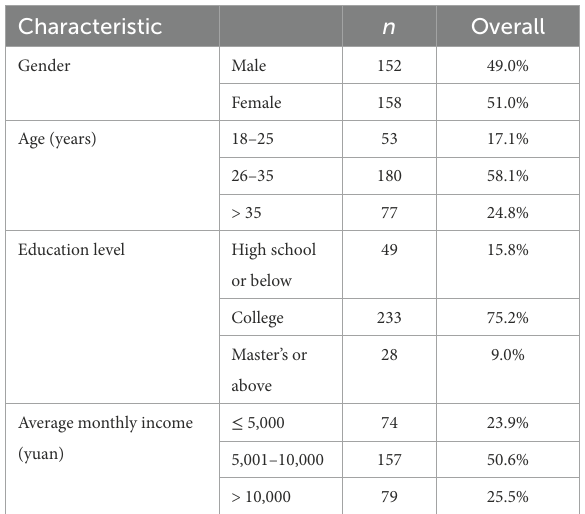
TABLE 1 Characteristics of participants in Study 1 ( N =